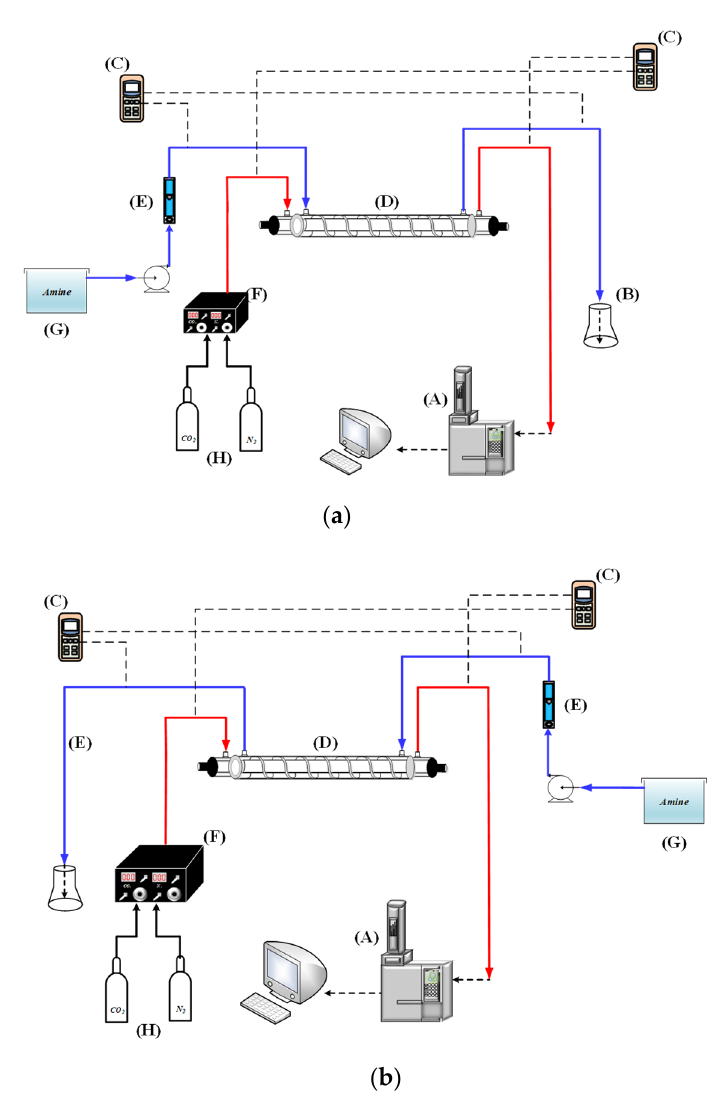
Figure 6. Experimental setup of spiral wired annulus channel in concentric-tube membrane module; (A) chromatograph; (B) beaker; (C) temperature indicator; (D) spiral wired concentric module; (E) flow meter; (F) mass flow controller; (G) thermostatic tank; (H) gas cylinder. ( a ) Concurrent-flow operations; ( b ) Countercurrent-flow operations.